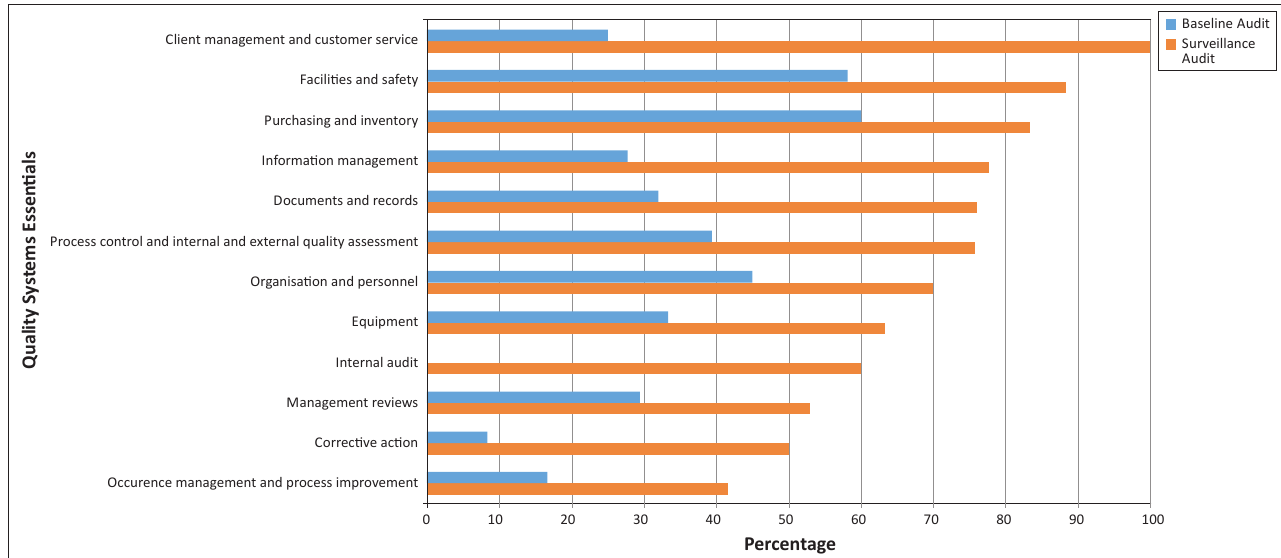
FIGURE 2: Median scores of the five laboratories in the 12 Quality System Essentials (QSEs).